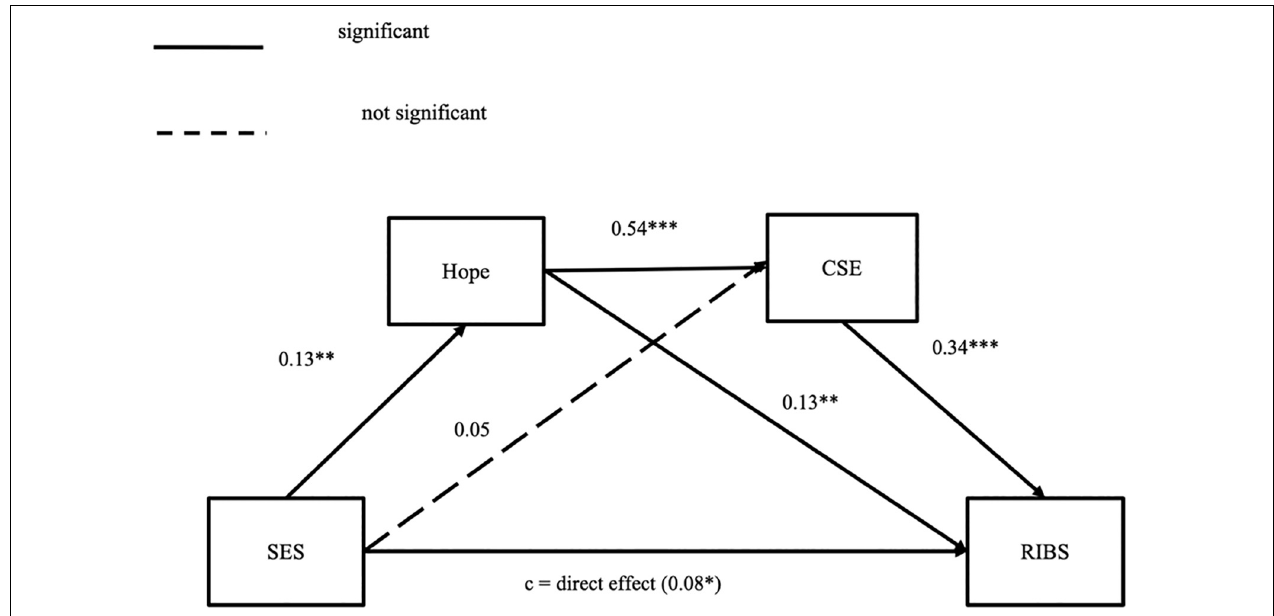
FIGURE 1 | Sequential mediation model regarding the mediating effects of hope and creative self-efficacy on the relation between SES and creativity. All the path coefficients were standardized. N = 607. *** p < 0.001; ** p < 0.01; * p < 0.05.